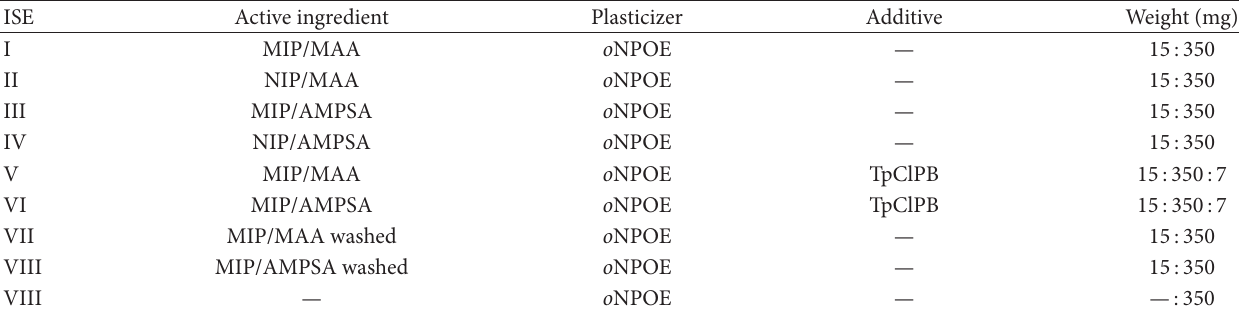
T 1: Membrane composition of LMG sensors cast in 200mg of